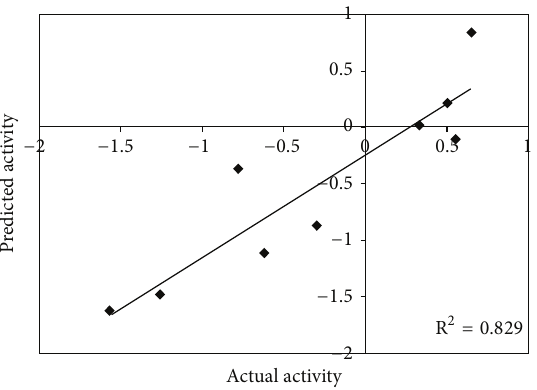
Figure 6: Plot of actual versus predicted values for the test set molecules with the help of FFNN statistical method.